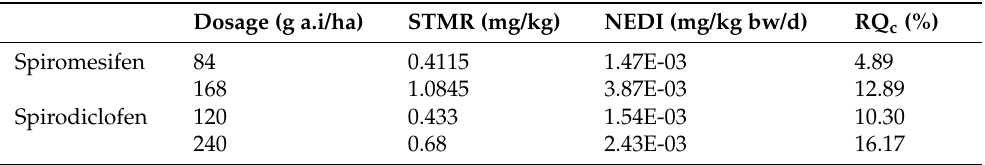
Table 6. Supervised trials median residue (STMR), national estimated daily intakes (NEDI), and chronic risk quotient (RQ c ) of spiromesifen and spirodiclofen in tomato fruits. Dosage (g a.i/ha) STMR (mg/kg) NEDI (mg/kg bw/d) RQ c (%) Spiromesifen 84 0.4115 1.47E-03 168